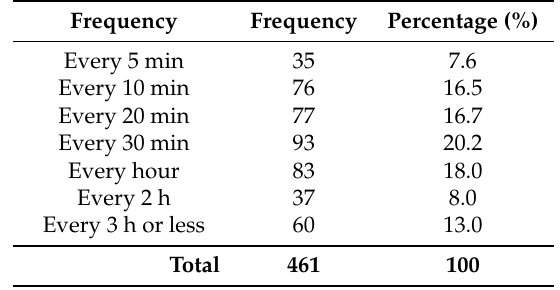
Table 6. How often do you think you usually check your smartphone or cell